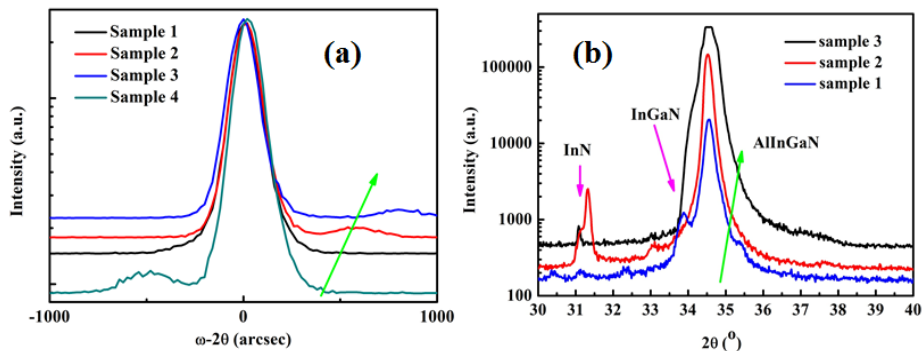
Figure 1. XRD spectra of Al x In y Ga 1 − x − y N/GaN layers with different trimethylaluminum (TMA) flow rate: ( a ) (0004) ω - 2θ scan; ( b ) 2θ scan .